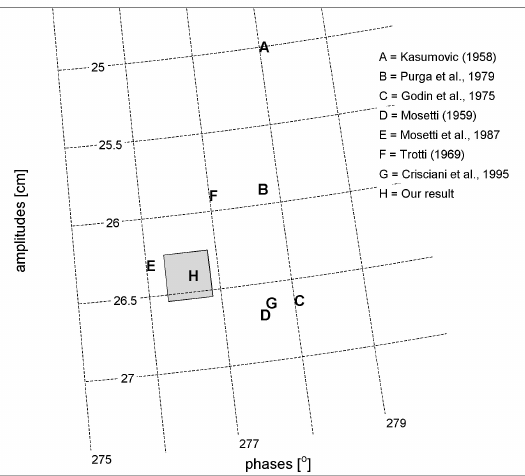
Fig. 2. Literature values for the amplitude and phase of the M2 tidal constituent (A–G) at the Trieste gauge station, and from our analysis (H); grey square around H marks the error bars.